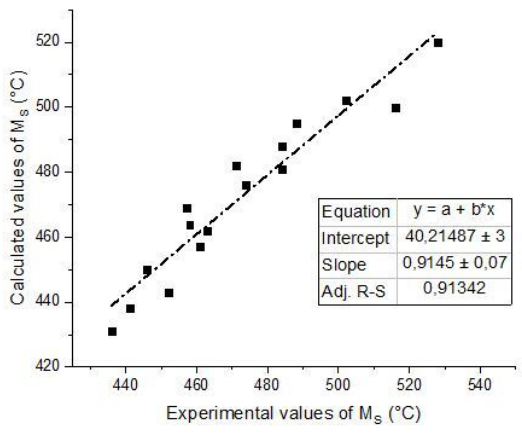
Figure 19. Calculated (Equation 1) versus experimental values of S M .